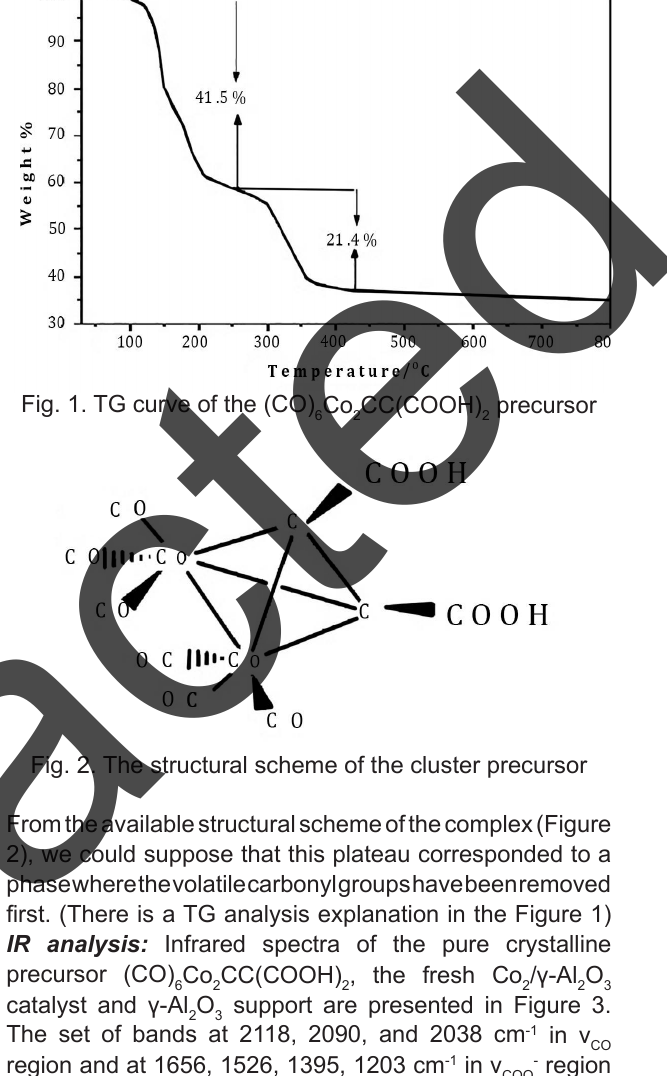
Fig. 2. The structural scheme of the cluster